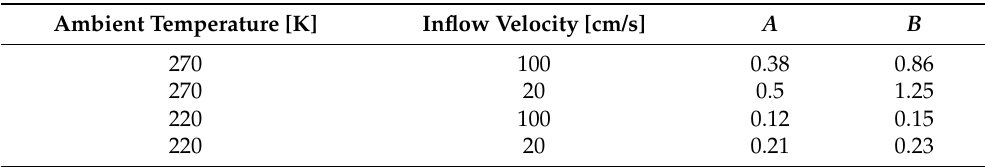
Table 4. Value of pre-constants, A and B , in Equations (14) and (15) for the various temperature- velocity